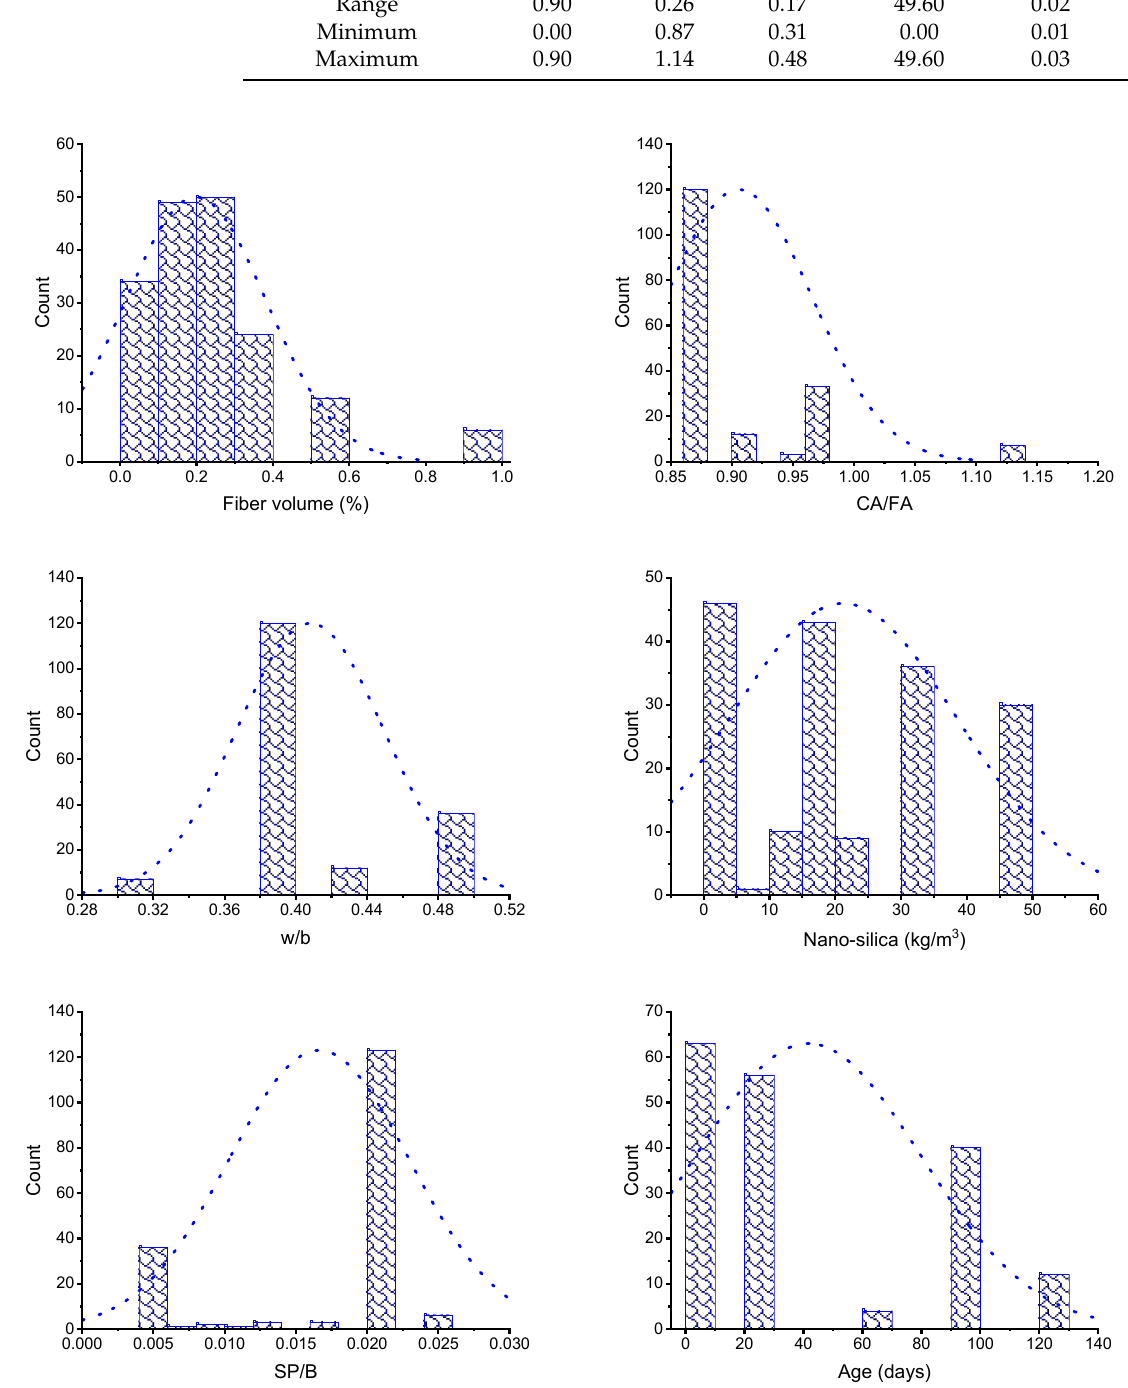
Figure 1. Input parameter’s relative frequency dispersion. Table 1. The outcomes of the descriptive assessment of input parameters.